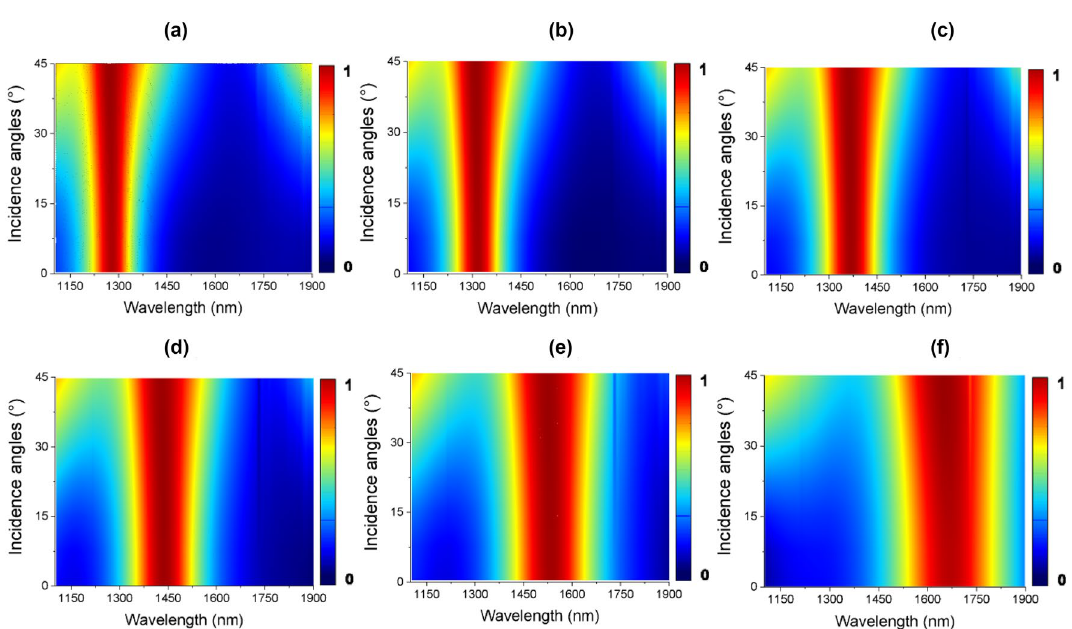
Figure 6. Dependence of the absorption for incident angles from 0° to 45° in TM polarization in the 1100– 1900 nm spectrum on: ( a ) amorphous phase ( m = 0%), ( b ) m = 20%, ( c ) m = 40%, ( d ) m = 60%, ( e ) m = 80%, and ( f ) crystalline phase ( m =